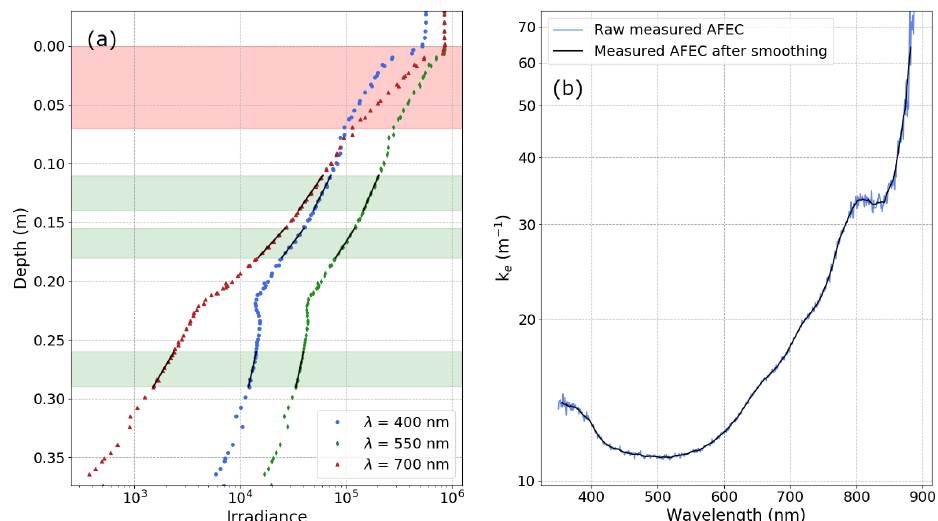
Figure 3. (a) Irradiance as function of depth for selected wavelengths for SOLEXS profile 002 on 13 February 2018. Green shading shows the zones of interest (ZOIs), which are homogeneous layers where the decrease in irradiance is visually linear on a logarithmic scale. The red shading corresponds to the part of the snowpack discarded due to the potential influence of direct light. (b) Measured AFEC (blue curve) and filtered AFEC (black curve) as a function of wavelength. Note that the ordinate scale is logarithmic.